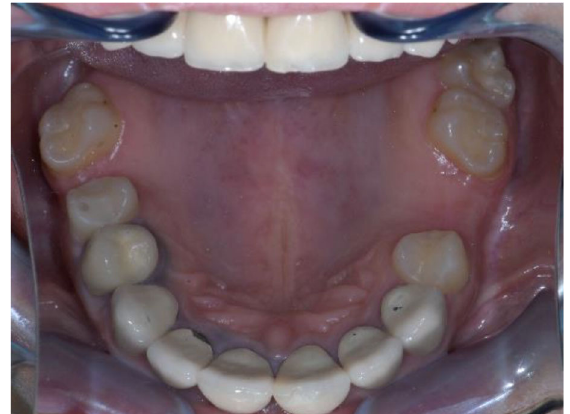
Figure 2. Upper jaw at initial